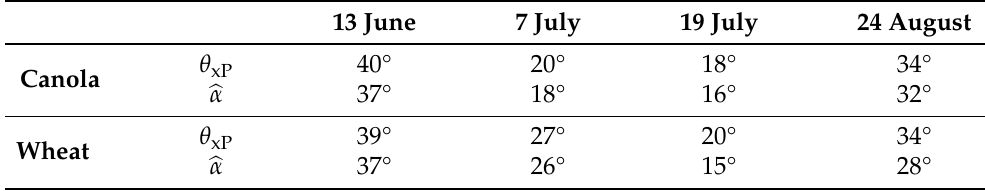
Table A1. Temporal variations of θ xP and (cid:98) α over canola and wheat at different